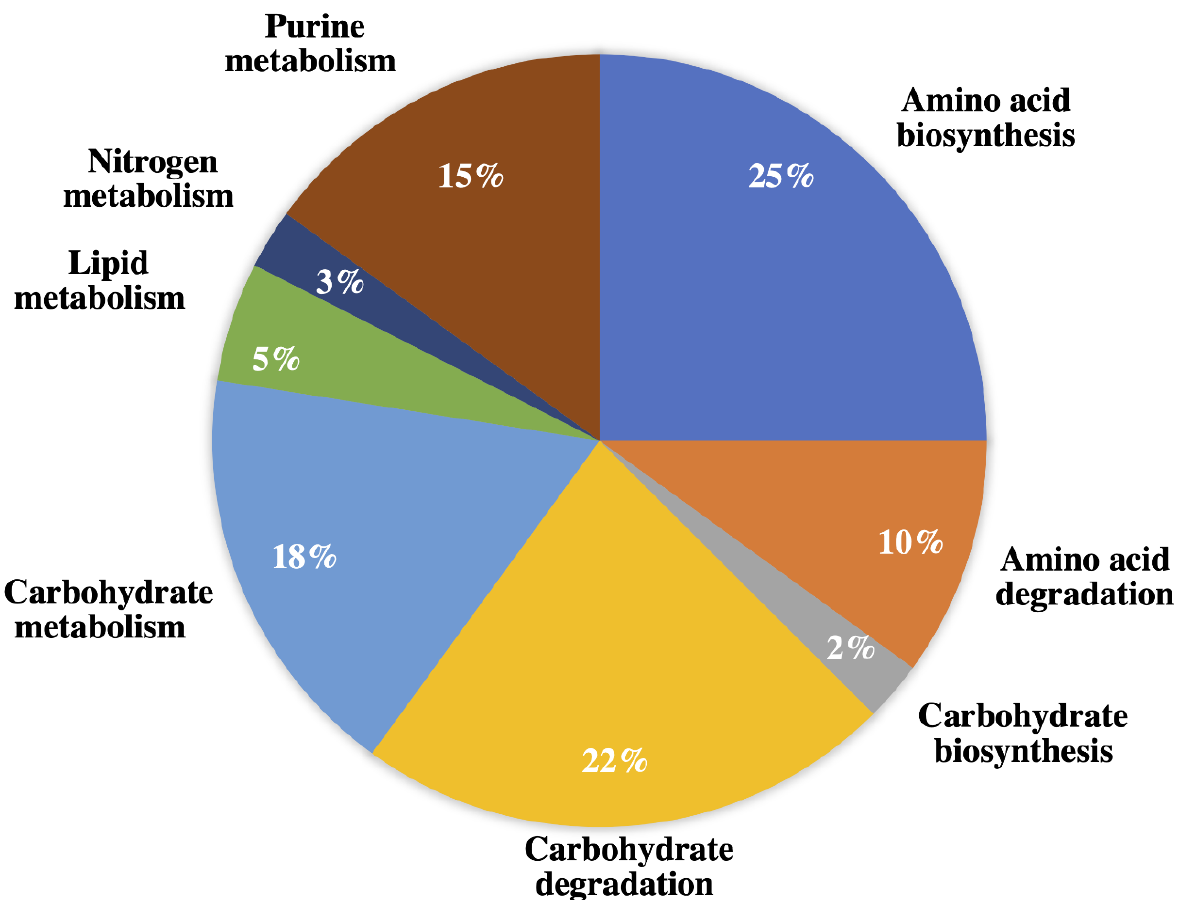
Figure 2. Distribution of proteins in P. bahamense based on annotated roles in biological pathways. Using NCBInr database search, the total proteins for two biological replicates were annotated using UniProt (https://www.uniprot.org/). A total of 93.5% of the total proteins identified were successfully mapped onto UniProtID for annotation. Identified proteins are involved in amino acid biosynthesis (25%), carbohydrate degradation (22%), carbohydrate metabolism (18%), purine metabolism (15%), amino acid degradation (10%), lipid metabolism (5%), nitrogen metabolism (3%), and carbohydrate biosynthesis (2%). Proteins from vegetative cells of P. bahamense were extracted using TCA precipitation, and shotgun proteome analysis was carried out using label-free quantitation through spectral counting.